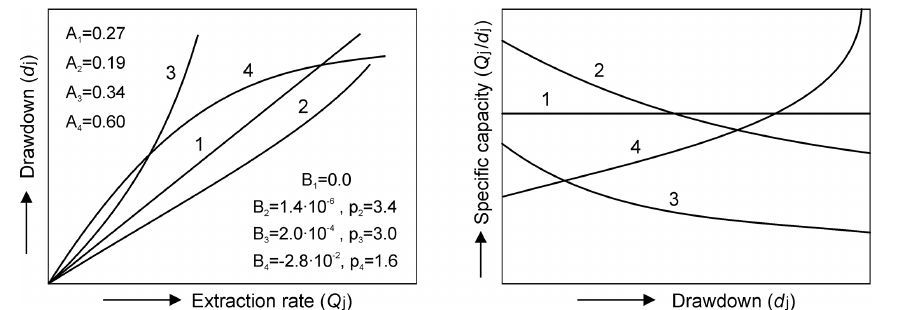
Figure 1. Characteristic curves (adapted from Villanueva and Iglesias, 1984), where A j , B j , and p j are the Jacob equation coefficients. (1) Confined aquifer without head losses in the well. (2) Free aquifer without head losses in the well. (3) Aquifer with non-linear head losses. (4) Anomalous curve due to, following conventional criteria, poorly collected data or changing characteristics in an aquifer with pumping